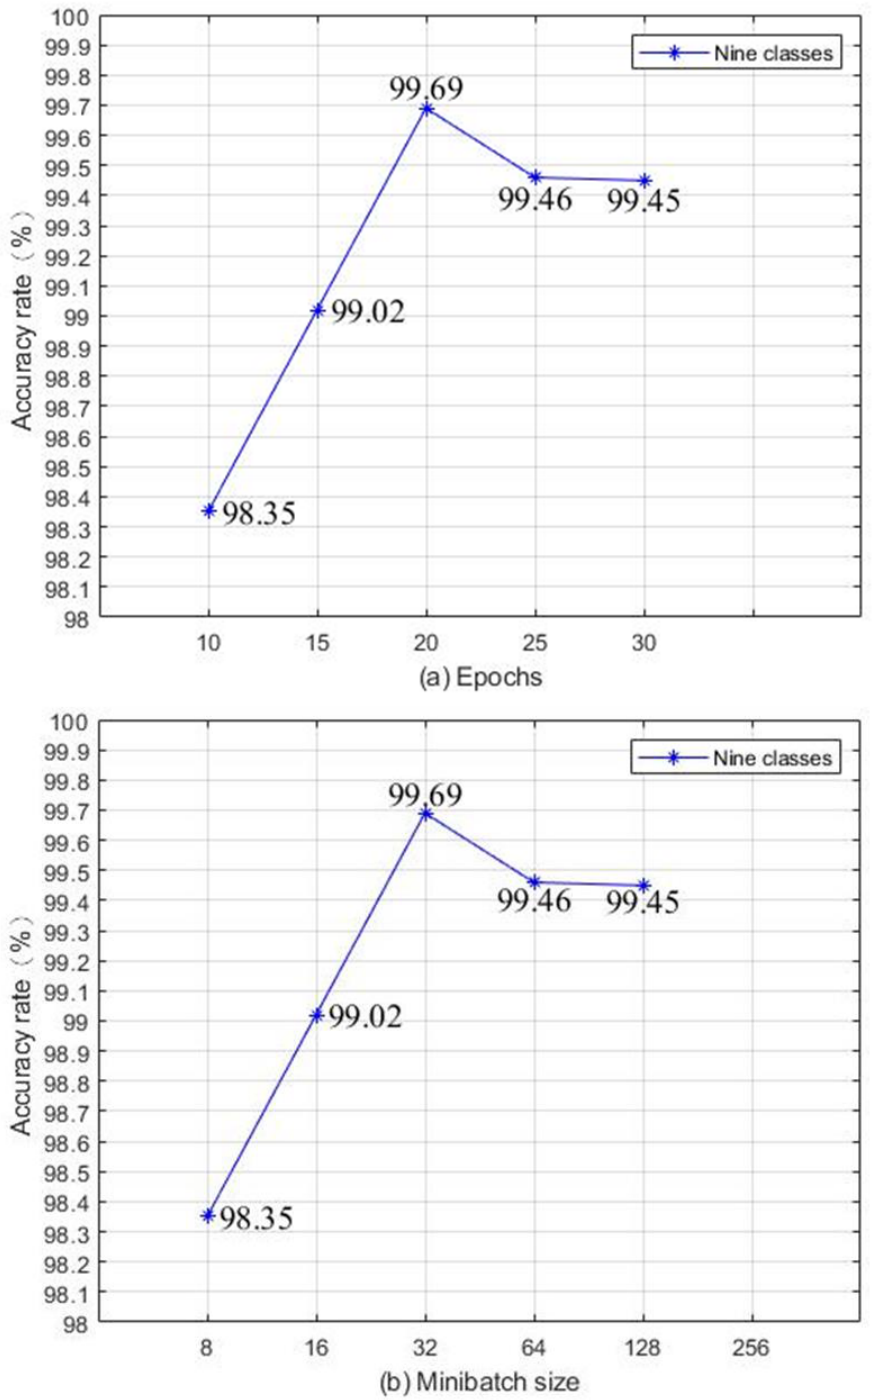
Figure 12. Illustration of the accuracy of nine tissue classes (CRC-VAL-HE-100K) using ( a ) epoch and ( b ) mini-batch